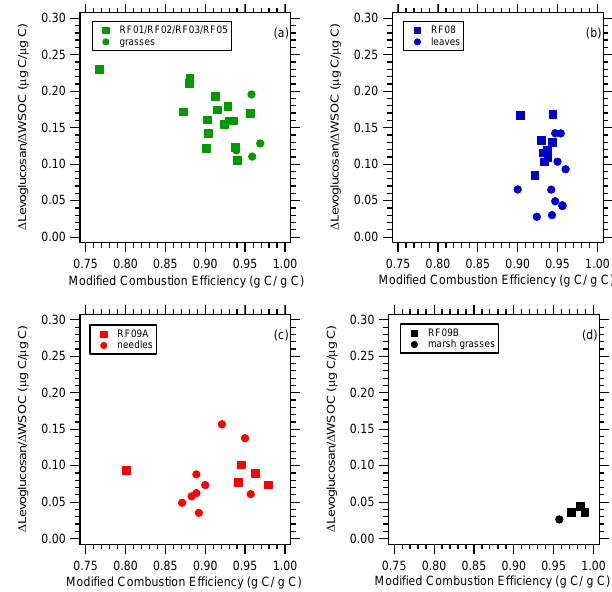
Figure 9. 1 Levoglucosan/ 1 WSOC ratio on a carbon mass basis for (a) RF01/RF02/RF03/RF05 and controlled laboratory burns in- volving grasses, (b) RF08 and controlled laboratory burns involv- ing leaves, (c) RF09A and controlled laboratory burns involving needles, and (d) RF09B and controlled laboratory burns involving marsh grasses as a function of modified combustion efficiency. In each plot the squares represent the prescribed burns and circles con- trolled laboratory